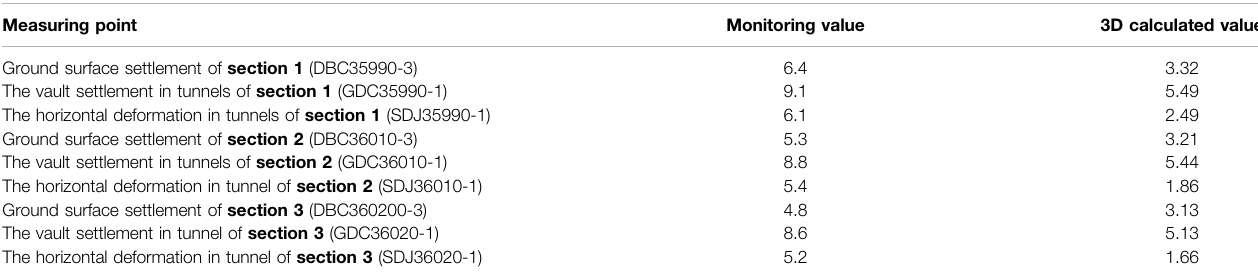
TABLE 5 | Comparison between the monitoring data and numerical simulation data (unit: mm). Measuring